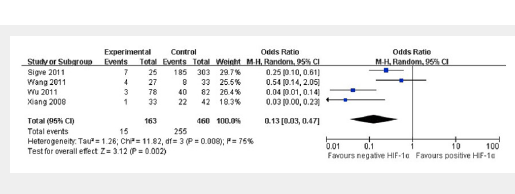
Figure 4 Forest plot of association between HIF-1α expression and 5-year survival rates.